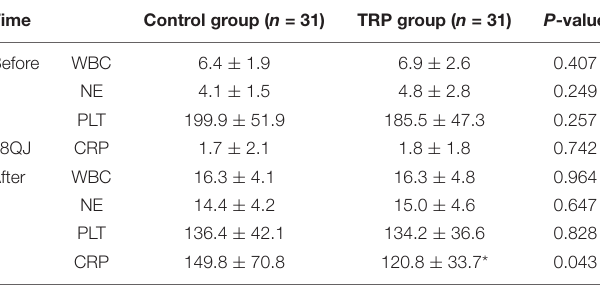
TABLE 4 | Routine blood tests before and 24 h after heart surgery.